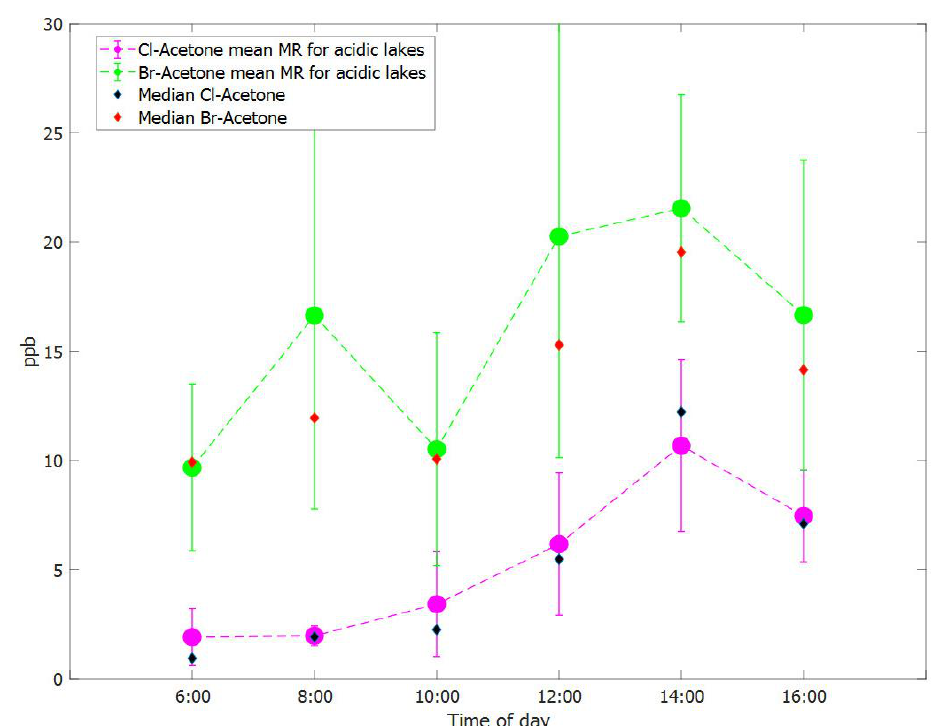
Figure 2. Mean measured mixing ratios of chloro- and bromoacetone from acidic lakes. Whiskers show maximum and minimum measured values and the diamonds median values.